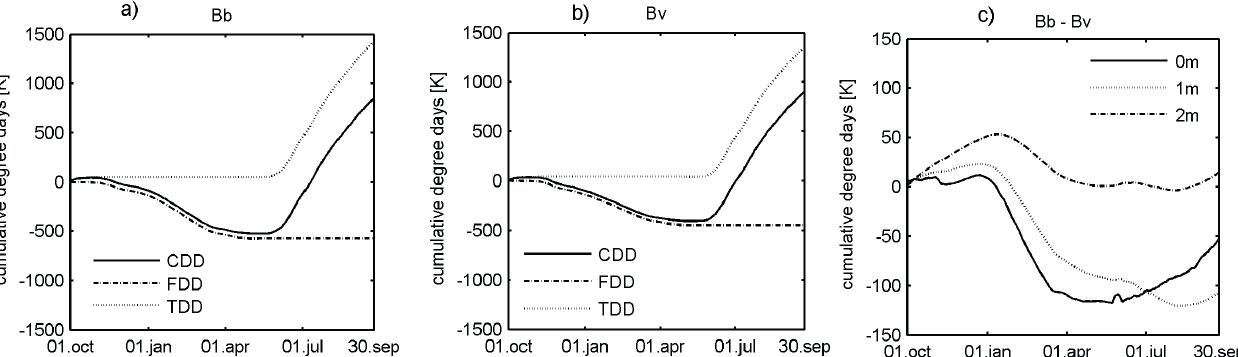
Fig. 8. Mean cumulative degree days (averaged over four years (2003, 2005, 2006, 2010)) at three different depths (0m (a), 2.5m (b) and 5m (c)) for the six boreholes. The air temperature is shown for comparison.